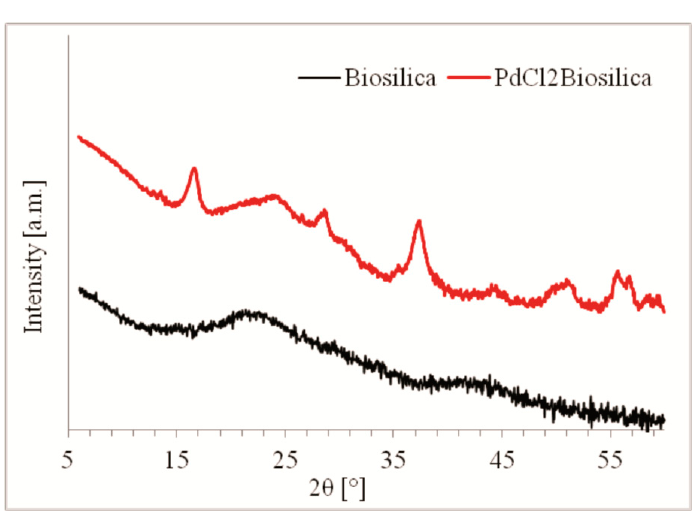
Figure 1. XRD patterns of the samples of pure diatom biosilica and palladium(II) chloride-doped diatom biosilica photocatalyst.